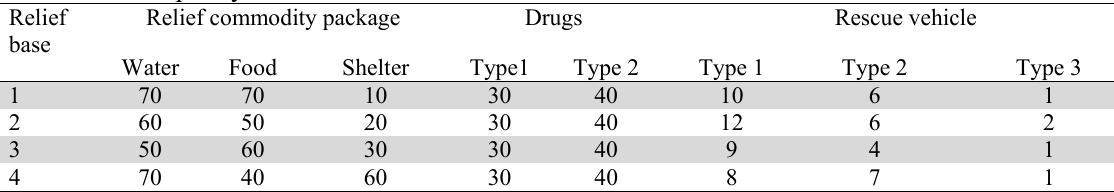
Warehouses’ capacity of aid commodities and rescue vehicles